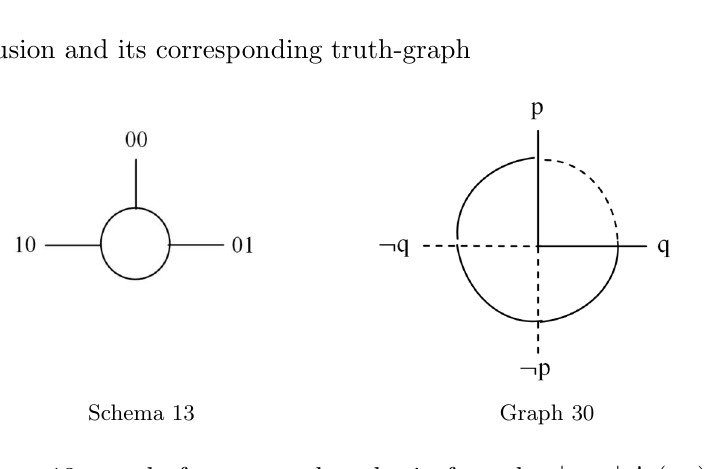
Schema 13 stands for a two-place basic formula: ⌊ p q ⌋ (pq), while graph 30 (also see graph 11(b)) stands for an assertion: ⊢ p →¬ q. Both schema 13 and graph 30 mean that the whole expression is true iff ‘p’ is true (has value 1) and ‘q’ is false (has value 0), or, ‘p’ is false and ‘q’ is true, or, both ‘p’ and ‘q’ are